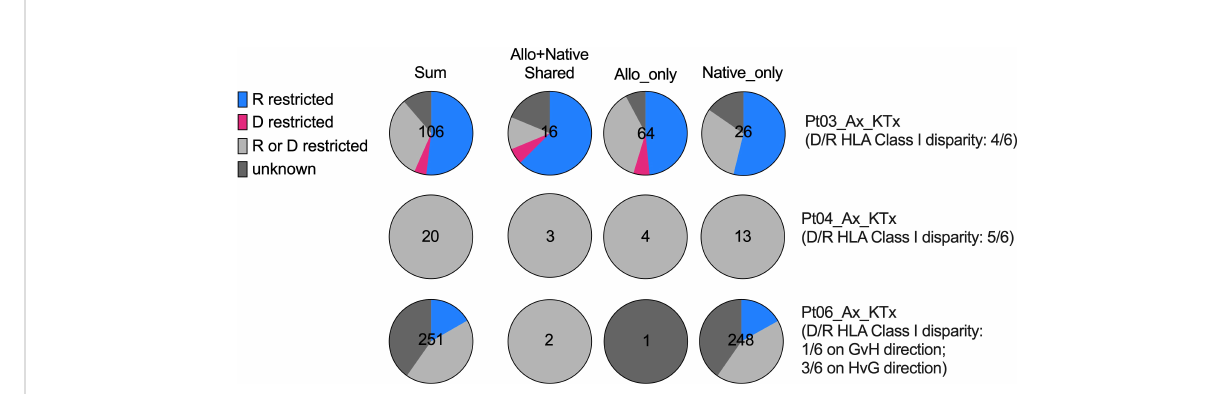
FIGURE 7 HLA restriction analysis of SARS-CoV-2-speci fi c TCRs de fi ned by bio_identity (CDR3 + v + j amino acid) overlap with MIRA database in Pts03, 04 and 06, from whom donor ( “ D ” ) and recipient ( “ R ” ) HLA typing information is available. Proportions of SARS-CoV-2-speci fi c TCRs characterized as “ R restricted ” , “ D restricted ” , “ R or D restricted ” and “ unknown ” are shown in the pie charts for each patient per row, with the fi rst column showing all SARS-CoV-2-speci fi c TCRs and the second, third and fourth columns showing SARS-CoV-2-speci fi c TCRs detectable in both allograft and native tissues, in allograft only and in native tissues only, respectively. The characterization of SARS-CoV-2-speci fi c TCRs in the “ R restricted ” , “ D restricted ” , “ R or D restricted ” and “ unknown ” categories is described in Table